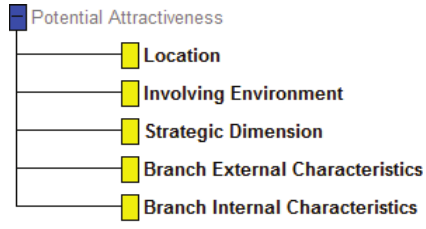
Figure 2. tree of